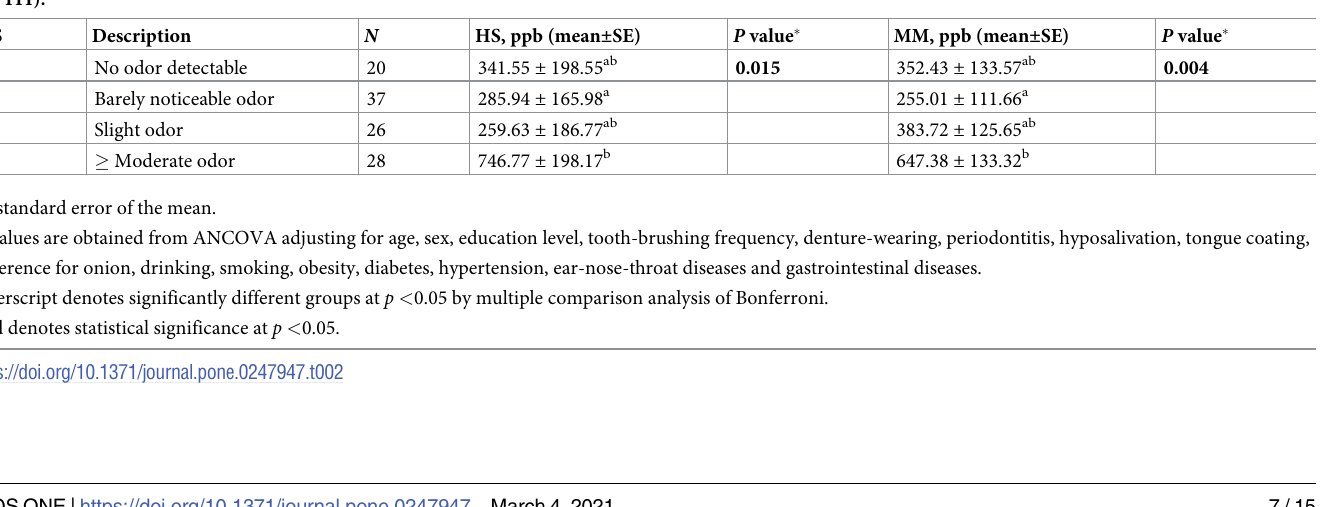
MM after adjusting for confounders (Table 2). For those assessed with higher OLS � 3, the mean concentration of HS and MM in mouth air was significantly higher than those with lower OLS. In addition, the adjusted mean OLS was significantly higher for the oral malodor positive group than the negative group controls (mean ± standard error [SE]: 2.51 ± 0.12 versus 0.65 ± 0.11, ANCOVA, p < 0.001) (Fig 2). Similarly, the significant association of higher VSC concentration with oral malodor was consistent for MM (mean ± SE: 501.44 ± 117.65 versus 249.56 ± 107.49, ANCOVA, p = 0.004) and marginally lost for HS (mean ± SE: 471.86 ± 177.70 versus 237.73 ± 162.34, ANCOVA, p = 0.067) after adjusting for confounders.